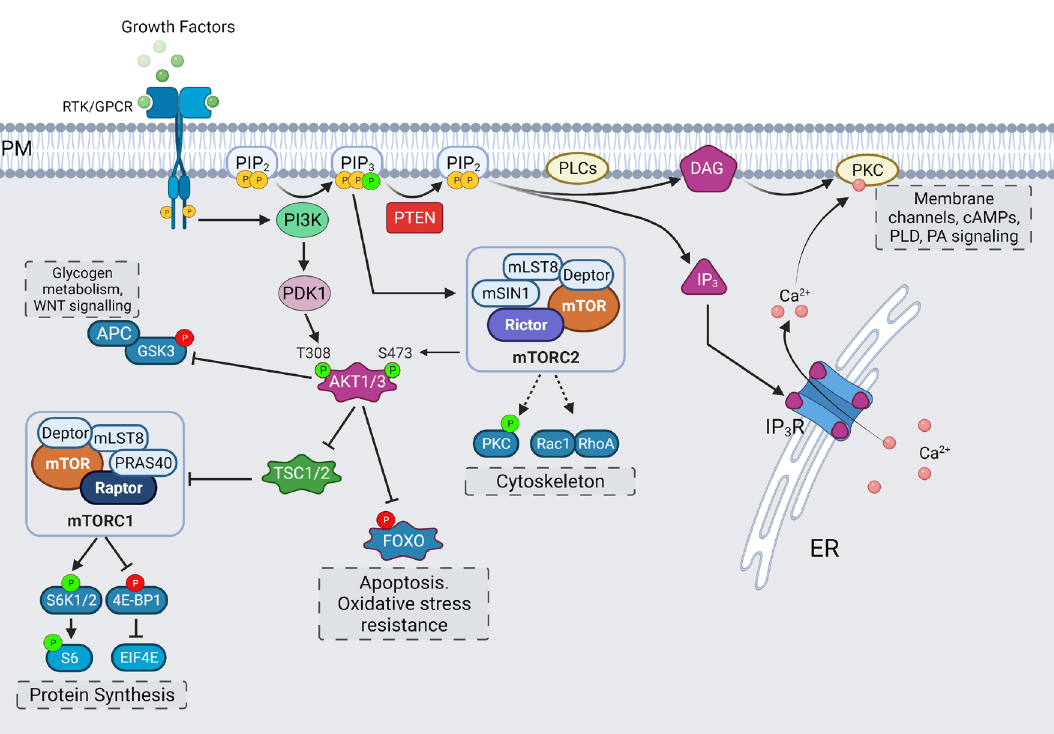
and PIP . The hydrolysis of PIP by PLC leads to formation of IP and DAG which are involved in intra- Figure 5. Effectors of PIP 2 3 2 3 cellular calcium release and activation of PKC-mediated signaling. PI3K-mediated synthesis of PIP leads to activation of AKT/ 3 mammalian target of rapamycin (mTOR) signaling pathway, with mTOR complexes, glycogen synthase kinase 3 (GSK3)β and Forkhead BOX O (FOXO) working as main effectors for regulation of processes of protein synthesis, cytoskeletal organization, and nutrient-sensing and survival. PTEN phosphatase keeps this activation in balance by dephosphorylation of PIP into PIP . 3 2 Activating phosphorylations are shown in green, while inhibitory phosphorylations are shown in red. 4E-BP1: eukaryotic initiation factor 4E-binding protein 1; EIF4E: eukaryotic translation initiation factor 4E; APC: adenomatous polyposis coli; Deptor: DEP domain-containing mTOR-interacting protein; mLST8: mammalian lethal with sec13 protein 8; mSIN1: mammalian stress activated protein kinase interacting protein; mTORC1: mammalian target of rapamycin complex 1; PDK: phosphoinositide-dependent protein kinase; PM: plasma membrane; PRAS40: proline-rich Akt substrate of 40 kDa; Raptor: regulatory associated protein of mTOR; Rheb: Ras homolog enriched in brain; Rictor: rapamycin-insensitive companion of mTOR; S6: ribosomal protein S6; S6K: ribosomal S6 kinase; TSC: tuberous sclerosis complex